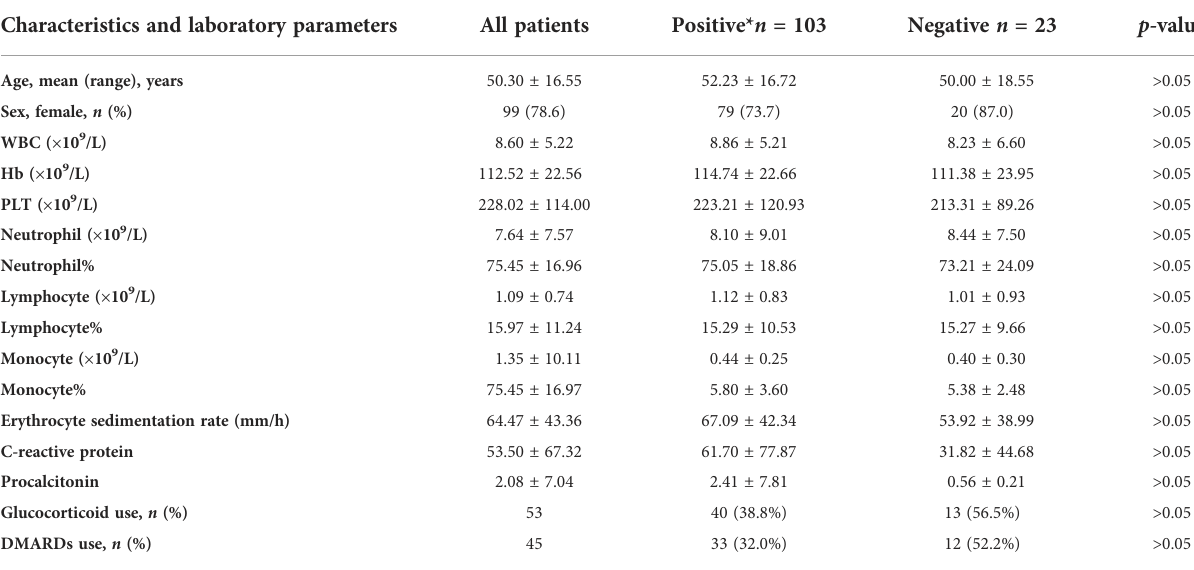
TABLE 1 Baseline characteristics of all patients. Characteristics and laboratory